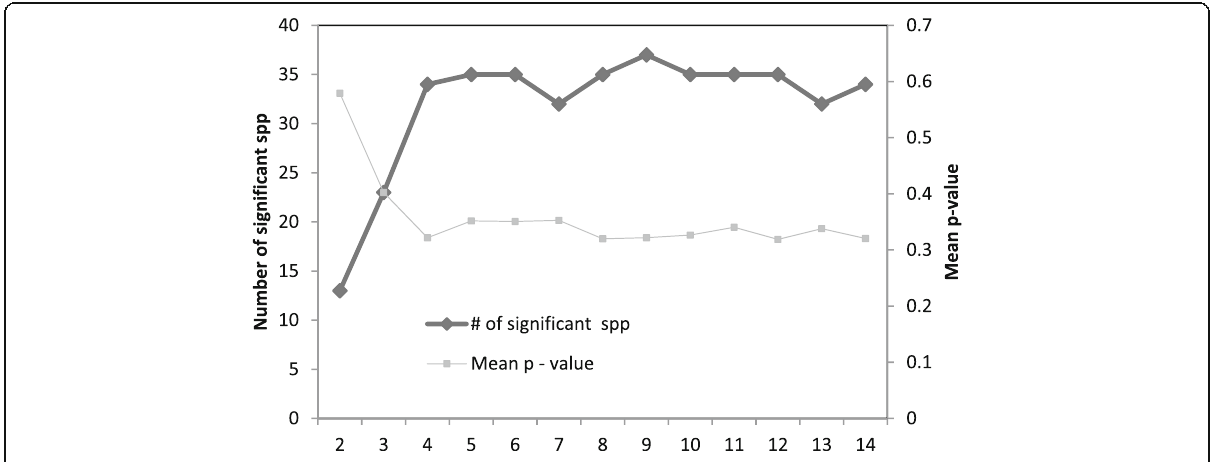
Fig. 3 Determination of number of ecologically meaningful clusters for weedy species classification